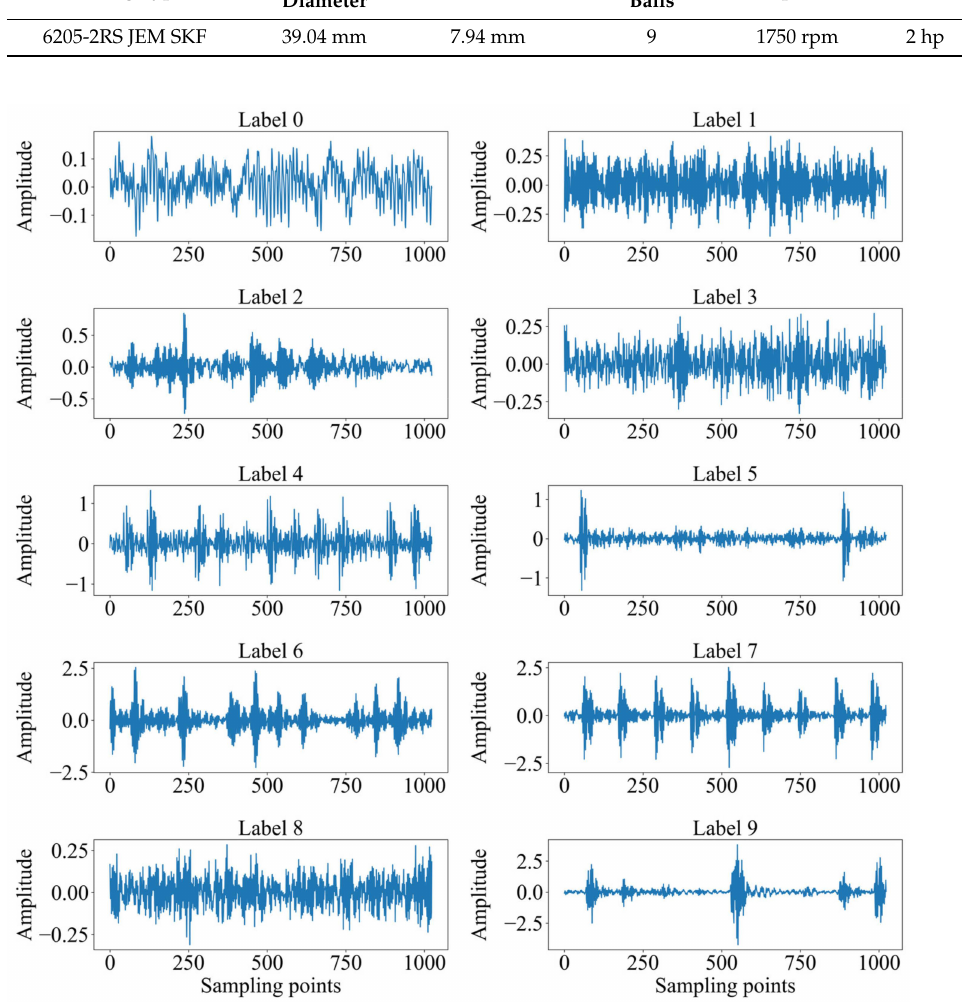
Figure 5. Time domain waveforms of the 10 kinds of samples in the bearing